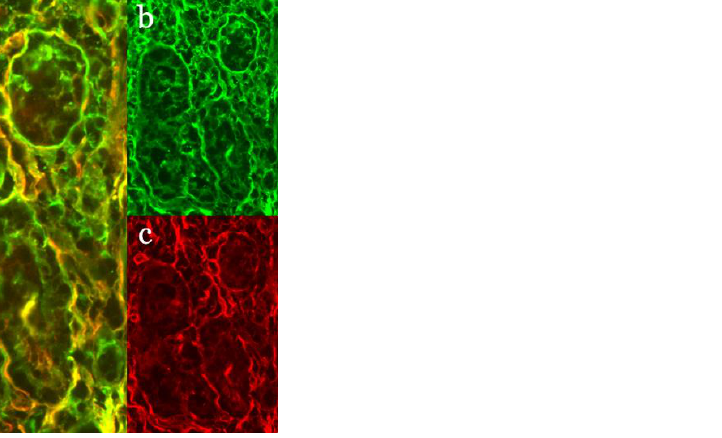
Figure 2. Small bowel mucosal biopsy of a celiac disease patient at the time of diagnosis of celiac disease stained for celiac disease-type IgA-tTG deposits. ( a ) Immunofluorescent staining demon- strating the colocalization of IgA and tTG (yellow); ( b ) staining for IgA (green), and ( c ) tissue transglutaminase (tTG) (red) in the same specimen. Magnification Table 1. Background and follow-up data and biopsy findings among nine patients with IgA nephropathy (IgAN). At IgAN Diagnosis At CD Diagnosis